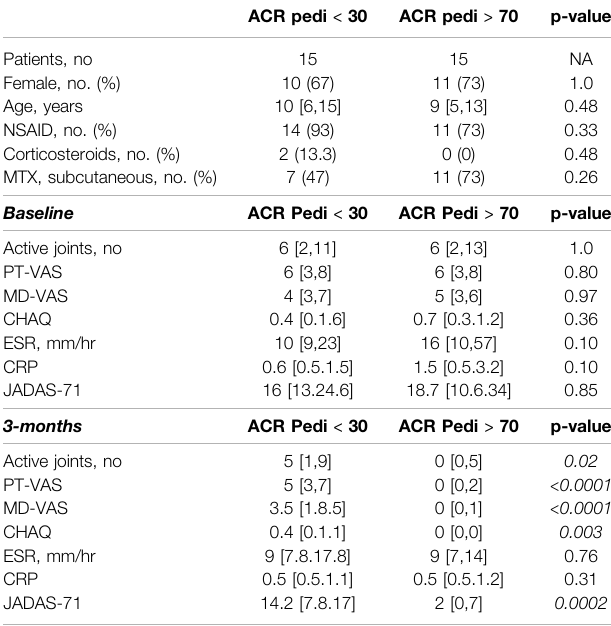
TABLE 1 | Patient demographic and clinical data. Following 3-months of MTX therapy, patients meeting the ACR Pedi 70 response criteria (ACR Pedi > 70) were considered responsive to MTX and patients failing to meet ACR Pedi 30 response criteria were considered non-responsive to MTX. The demographics, concomitant medications, route of MTX administration, and baseline and 3- months measures ofdisease activity are included and compared betweenthe two groups (comparisons resulting in a p-value < 0.05 are italicized). Baseline clinical data are representative of the larger cohort from which these samples were chosen (data not